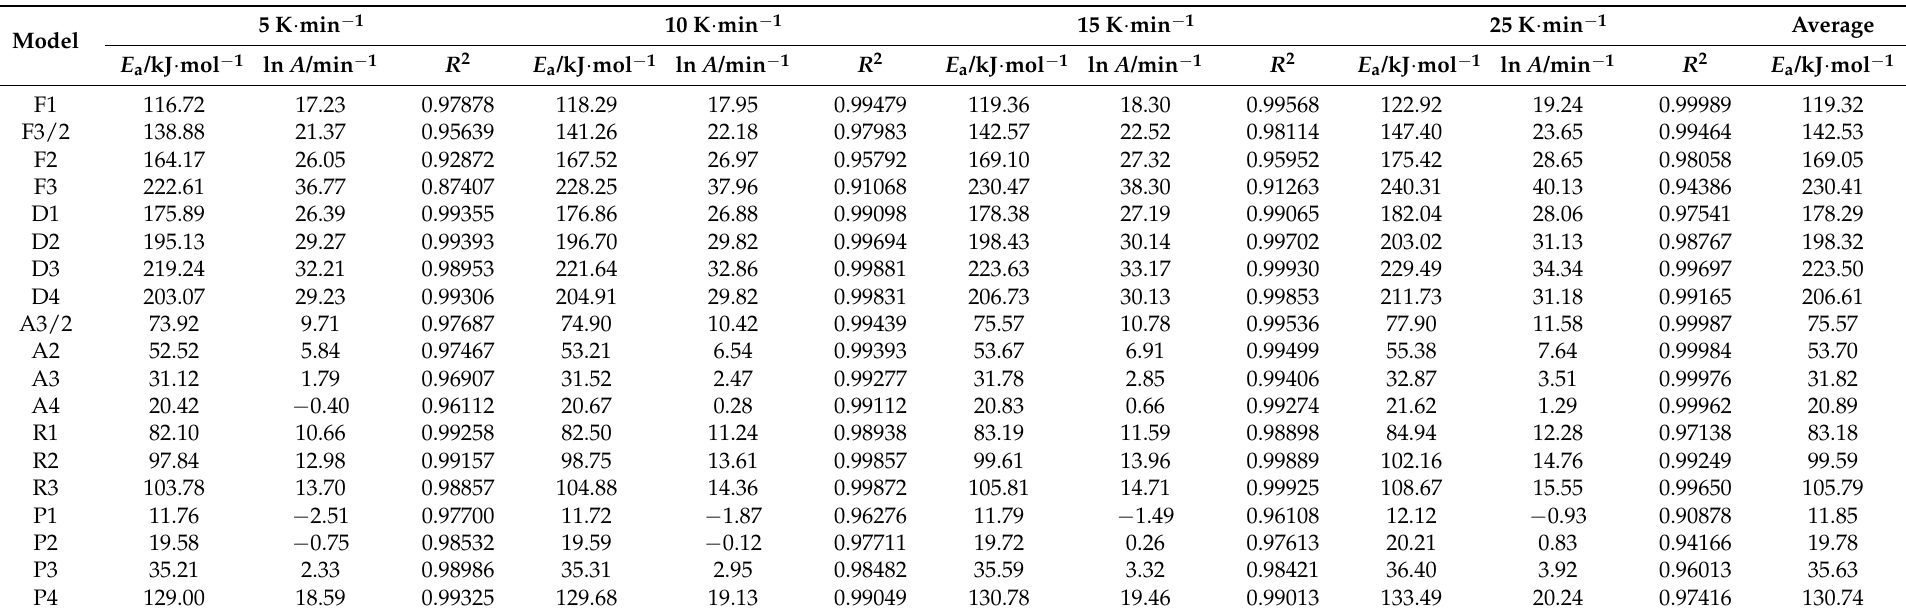
Table A4. The kinetic parameters of the second pyrolysis stage of NOC calculated by CR method at different heating rates.